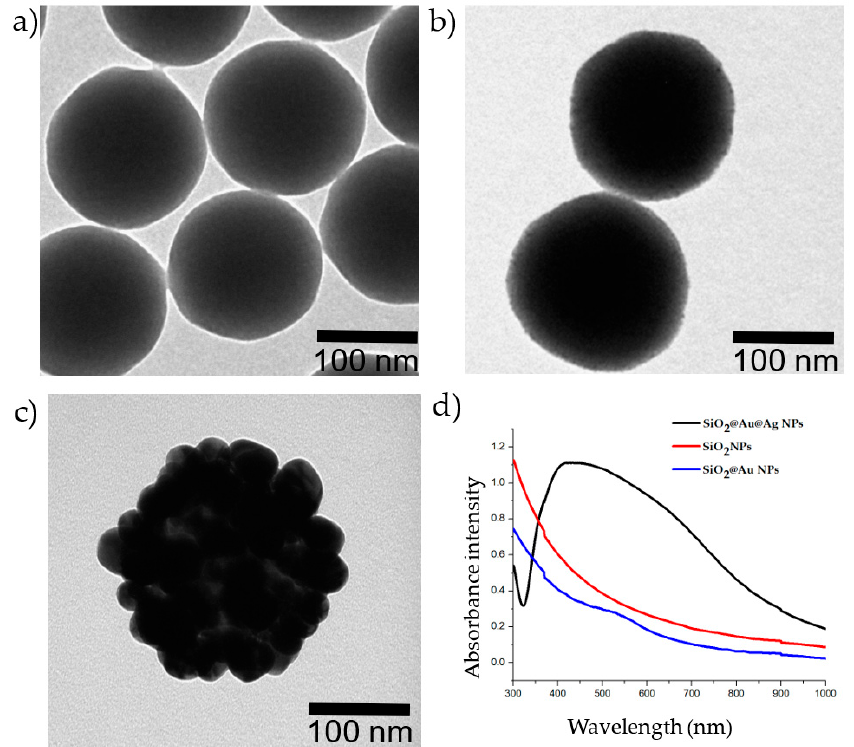
Figure 1. Images of the nanoparticles and UV–Vis absorbance of the nanoparticles. ( a ) Transmission electron microscopy (TEM) image of silica (SiO 2 ) NPs; ( b ) TEM image of SiO 2 @Au NPs; ( c ) TEM image of SiO 2 @Au@Ag NPs; ( d ) UV–Vis absorbance of NPs. Red: 1000 μ g/mL SiO 2 NPs; blue: 250 μ g/mL SiO 2 @Au NPs; black: 20 μ g/mL SiO 2 @Au@Ag NPs.